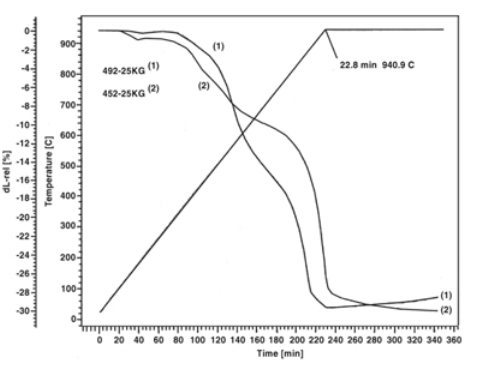
FIGURE 3 Dilatometer analysis of 98:2 powders #452 (Ag = Pd) and #492 (Ag